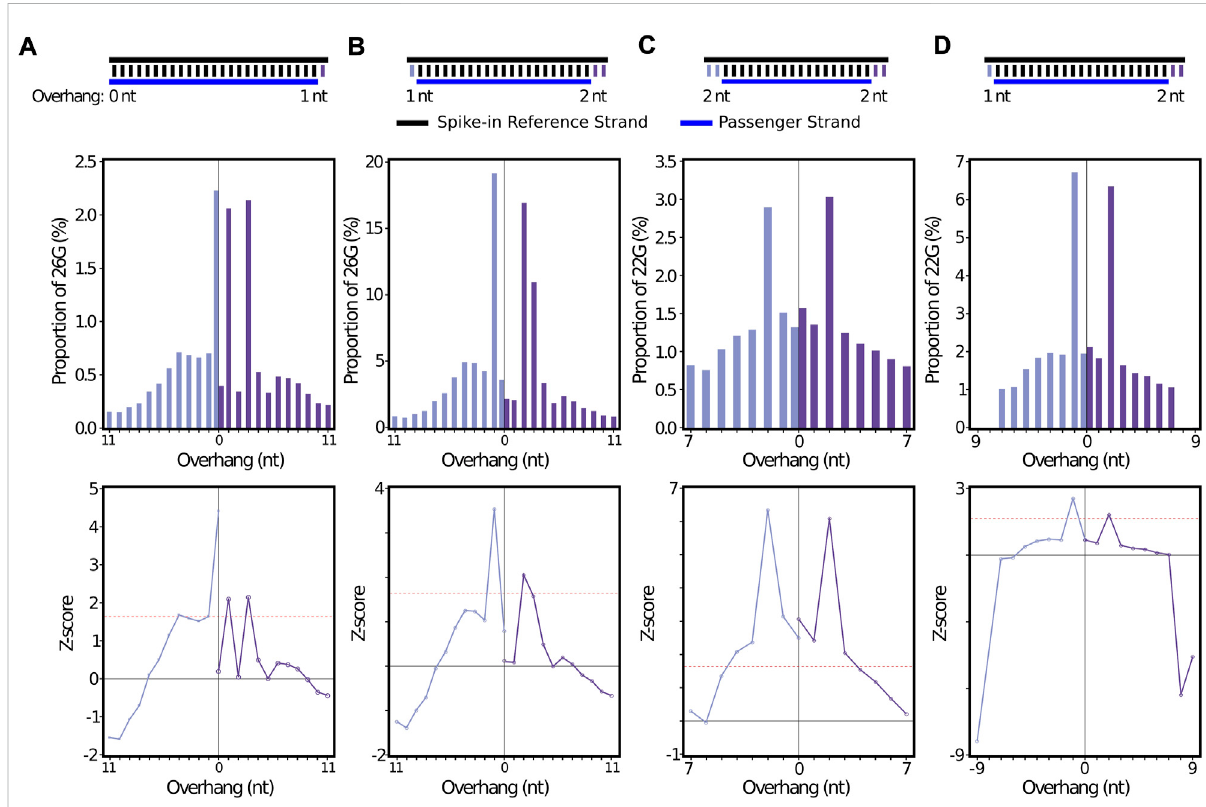
FIGURE 7 stepRNA can identify an in silico sRNA spike-in dataset in biological data. A total of 5000 simulated 24 nt sRNAs and their associated passenger sequences were added to the biological dataset used in Figure 3. The in silico spike-in duplexes, including the reference and passenger sequence length and overhang distances are illustrated above the bar graphs. A single referencesRNA read was randomly selected and spiked-in 5000x to the non-collapsed (A) 26G(n=303,233)or (C) 22G(n=302,979)data.For (BandD) non-identical24-ntreferenceswereaddedtothecollapsed (B) 26G( n =33,651)or (D) 22G(n=111,723)siRNAreads.Bargraphsrepresentthepercentage ofreads with an overhang length for the spiked-in 26G (A and B) or 22G (C and D) in a C. elegans sRNA biological data set (Fischer et al., 2011) (GEO: GSE32366). The 5 ′ overhangs are coloured light purple, 3 ′ overhangs are coloured dark purple. Z-scores are shown for all data sets. Red line indicates p =